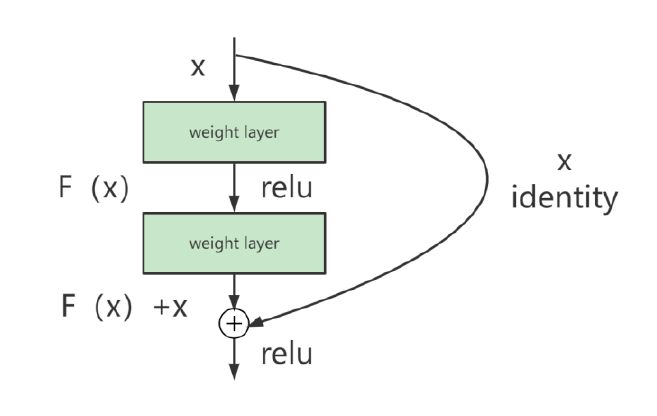
shown in Figure 11. Pointwise perform channel fusion on the feature map after Depthwise convolution. Among them, Depthwise corresponds to grouped convolution, and Pointwise corresponds to concatenated